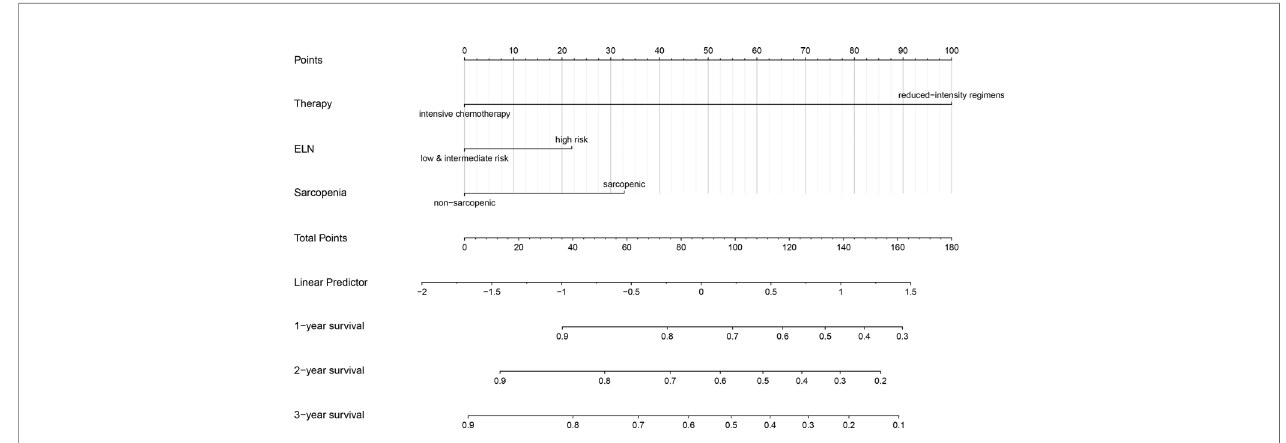
FIGURE 5 | Nomogram for predicting 1-, 2- and 3-year overall survival rates. A new nomogram for predicting OS was constructed by the three signi fi cant prognostic factors (therapy, ELN risk, and sarcopenia) determined by the Cox regression analysis. The nomogram was plotted by ‘ R, version 4.0.5 ’ . OS, overall survival; ELN, European Leukemia Net.